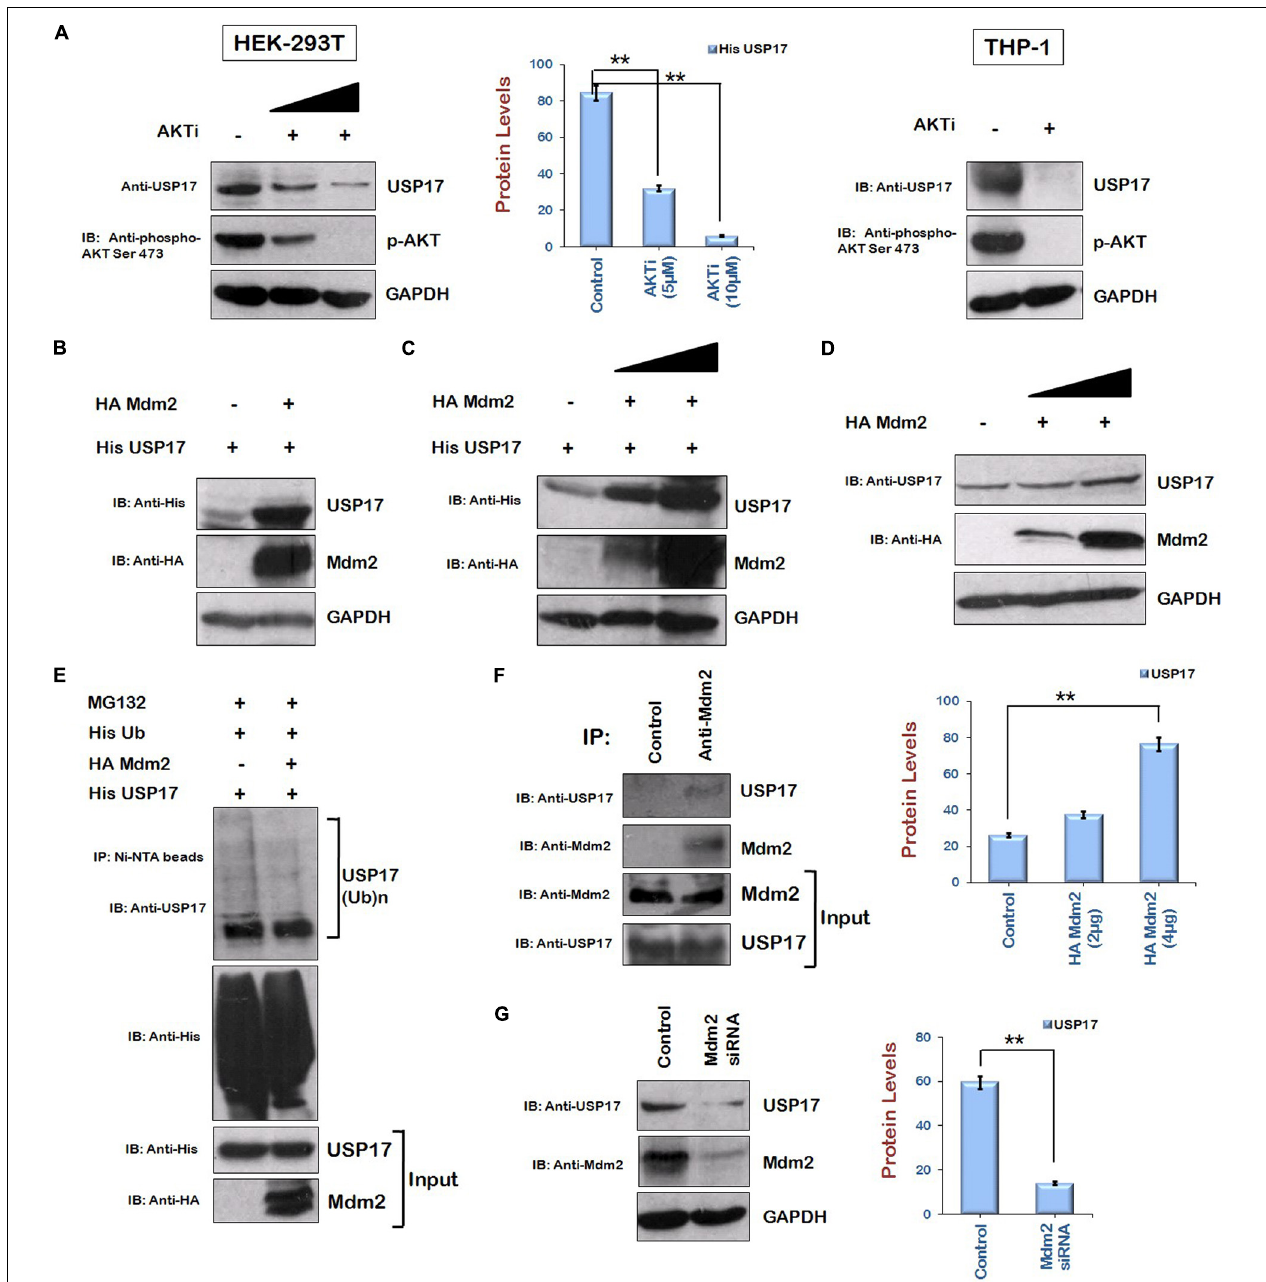
FIGURE 5 | Mdm2 stabilizes the expression of USP17 in ubiquitin-dependent manner. (A) HEK-293T and Thp-1 cells were treated with AKTi as indicated for 24 h. Cell lysates were subjected to Western blotting using anti-USP17, anti–phospho-AKT Ser473, and anti-GAPDH antibodies. (B) HEK-293T cells were cotransfected with His USP17 and HA Mdm2 plasmids for 24 h. Cell lysates were analyzed by Western blotting using anti-His, anti-HA, and anti-GAPDH antibodies. (C) HEK-293T cells were transfected with His USP17 and increasing amounts of HA Mdm2 encoding plasmid. After 24 h of transfection, cell lysates were subjected to Western blotting using anti-His, anti-HA, and anti-GAPDH antibodies (D) HEK-293T cells were transfected with increasing amounts of HA Mdm2 plasmid for 24 h. Cell lysates were analyzed by Western blotting using anti-HA, anti-USP17, and anti-GAPDH antibodies. (E) HEK-293T cells were cotransfected with His Ub, His USP17, and HA Mdm2 for 24 h. Cells were treated with MG132 (20 µ M) for 8 h. Cell lysates were subjected to immunoprecipitation with Ni-NTA beads followed by Western blotting with anti-USP17 antibody. (F) HEK-293T cell lysates were subjected to immunoprecipitation using anti–Mdm2 antibody–bound agarose beads followed by Western blotting using anti-USP17 antibody. (G) HEK-293 T cells were transfected with siRNA specific to Mdm2. After 48 h of transfection, cell lysates were subjected to Western blot analysis using anti-USP17, anti-Mdm2, and anti-GAPDH antibodies. Densitometry analysis was performed using ImageJ and shown as bar graph with error bars. GAPDH was used as loading control. Data obtained are presented as mean ± s.e.m. of three independent experiments. p -value was calculated by two-tailed t -test (** p < 0.01).